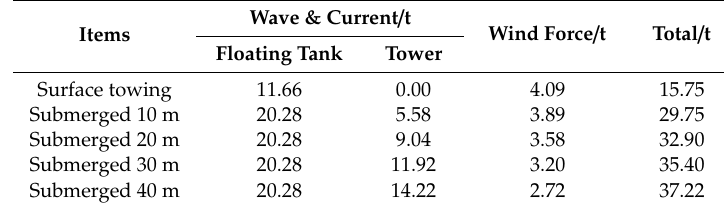
Table 2. Towing resistance by CCS code.